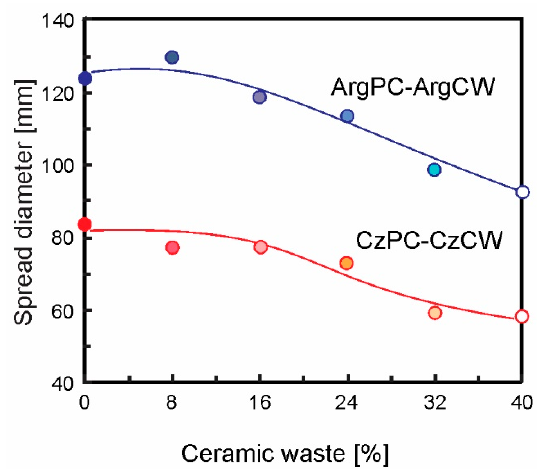
Figure 4. Results of the mini-slump test expressed as initial spread diameter of cement pastes containing di ff erent amounts of ceramic waste